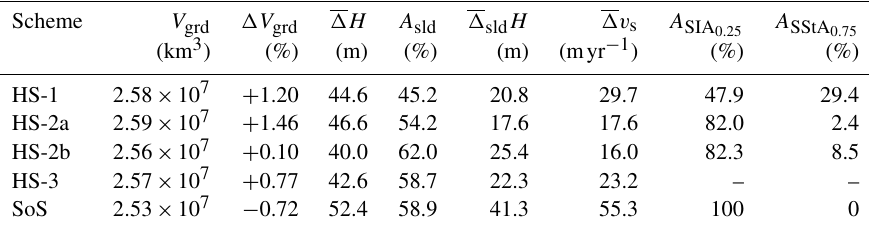
Table 3. Summary of the results at the end of the calibration procedure for each of the applied hybrid schemes (HS, see Sect. 2.2) and SIA-only scheme (SoS), including the total grounded ice volume, V grd (km 3 ); a deviation from the total grounded ice volume, (cid:49)V grd (%); a mean absolute error in the ice thickness, (cid:49)H (m); a fraction of the total area where basal sliding occurs, A sld (%); a mean ice thickness error only where basal sliding operates, (cid:49) sld H (m); a mean surface velocity error, (cid:49)v s (myr − 1 ); a fraction of the grounded ice area dominated (%); and a fraction of the grounded ice area dominated by the SStA (only where w > 0 . 75), by the SIA (only where w < 0 . 25), A SIA 0 . 25 A SStA 0 . 75